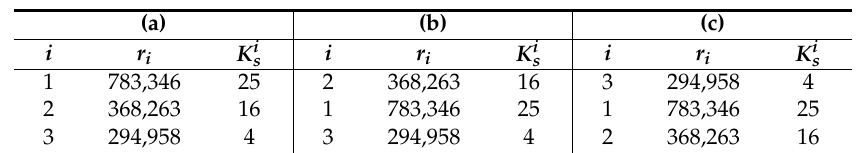
Table 2. RSU1(a), 2(b) and 3(c) key table.